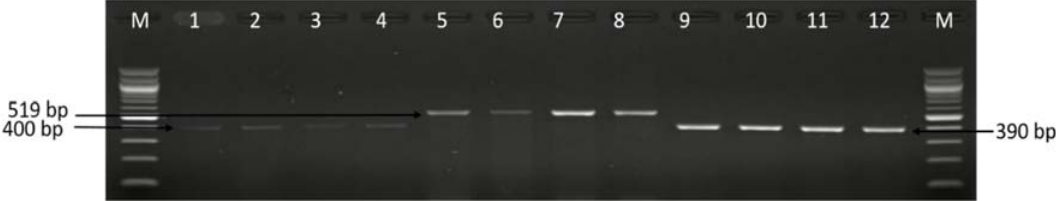
Figure 6. A representative gel image of some of the PCR detected iam , cadF and fldR genes. Lane 1–4: positive Campylobacter isolates that harbor cadF gene (400 bp), lane 5 ‐ 8: positive Campylobacter isolates that harbor iam gene (519 bp), lane 9–12: positive Campylobacter isolates that harbored flgR gene (390 bp).